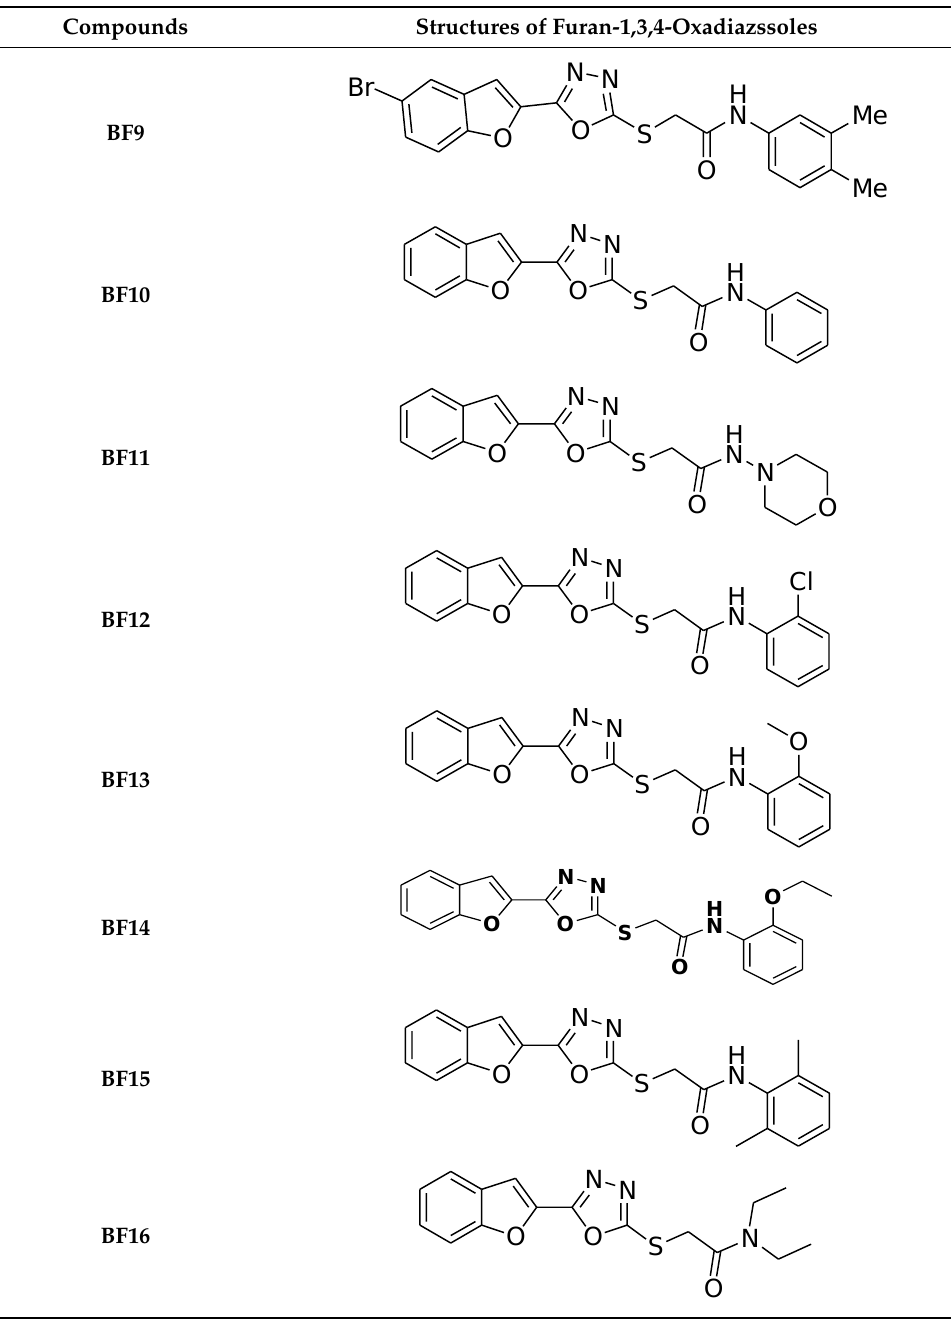
Table 5. Cont. Compounds Structures of